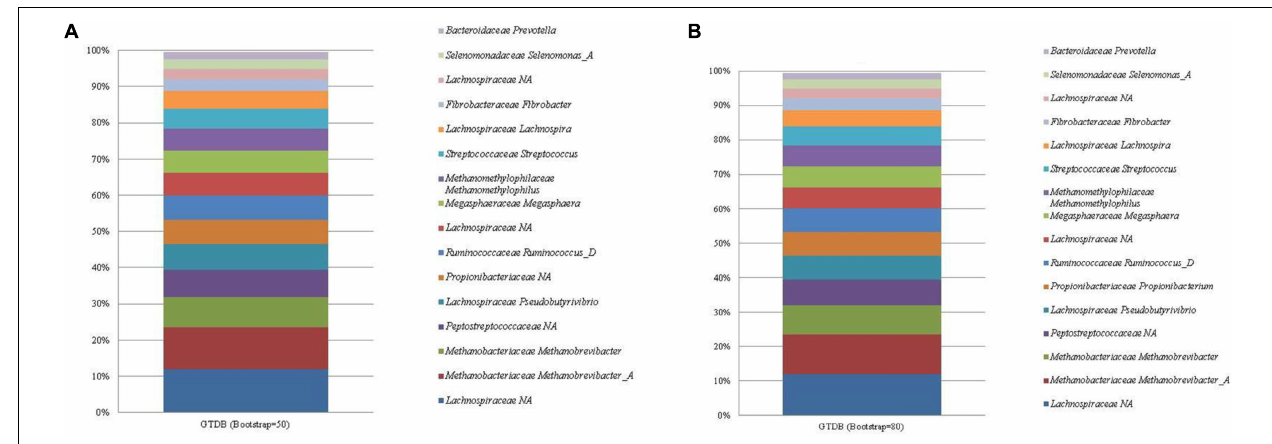
FIGURE 1 | The mean relative abundance and GTDB classification (family and genus) of the 16 most abundant sequences in libraries generated from the rumen specific reference standard. Bootstrapping threshold: (A) 50 and (B) 80.